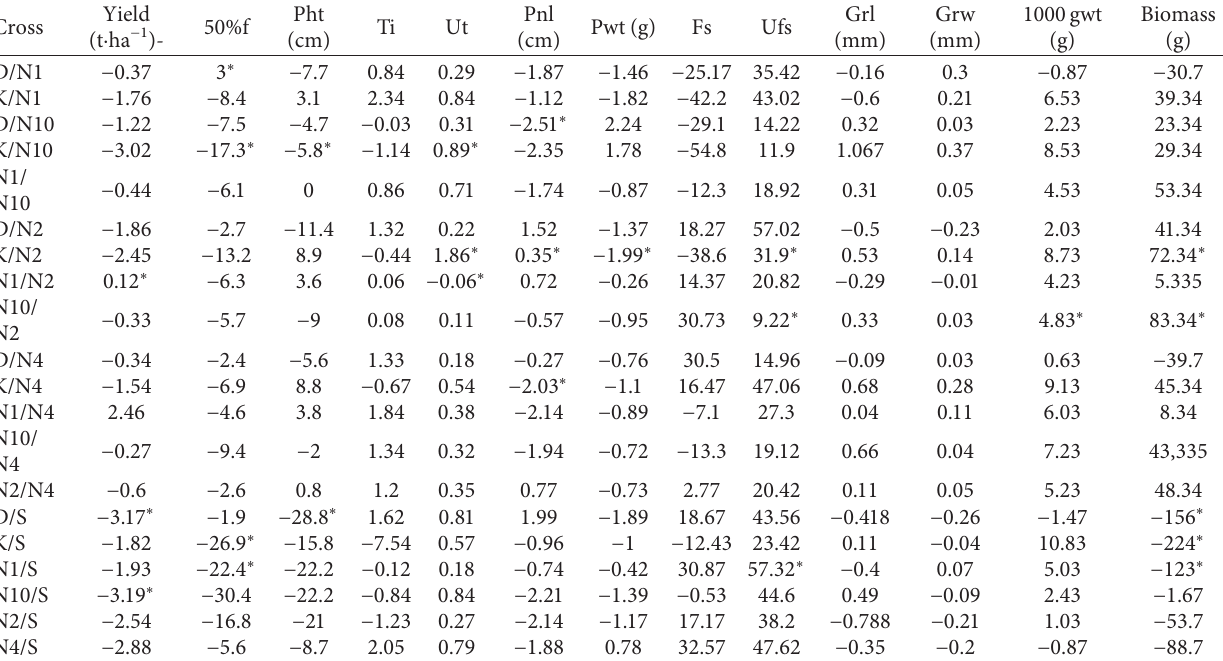
Table 4: Specific combining ability effects for crosses at KALRO, Mtwapa, and Bahari during the long rain season of 2018.